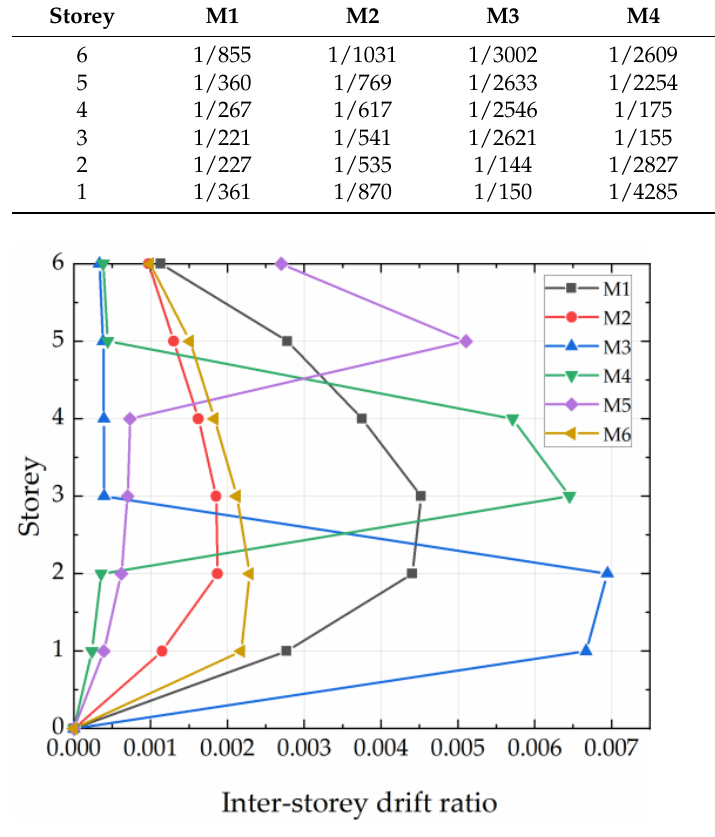
Figure 9. The interstorey drift ratio of six models at the performance point. The distribution of the plastic hinge of six frame models with different arrangements of infill walls at the maximum interstorey drift ratio of 2% (collapse limit state) is shown in Figure 10. The serial numbers in each figure represents the order of plastic hinge occurrence. As shown in Figure 10a, the plastic hinges are developed at the ends of most beams of the bare frame M1 and at the bottom of the bottom columns. The number of plastic hinges developed in the M2 is 24% fewer than that of M1 because the regular arrangement of infill walls in frames increases the lateral stiffness and decreases the deformation of the frame structure. For the models M3, M4, and M5 with an irregular arrangement of infill walls in the vertical direction, plastic hinges usually occur firstly at the ends of beams at the storeys with the absence of infill walls. As the lateral load continued to increase, the plastic hinges gradually occured at the ends of columns on the same storeys. Due to the irregular arrangement of infill walls, the lateral stiffness of the storeys without infill walls is much smaller than that of the adjacent upper and lower storeys, which forms weak storeys. The deformation is concentrated in these weak storeys, and the damage is also concentrated in these storeys. For the frame without infill walls in the M6 midspan, the plastic hinges first occur at the beam ends of the midspan. After most of the midspan beams